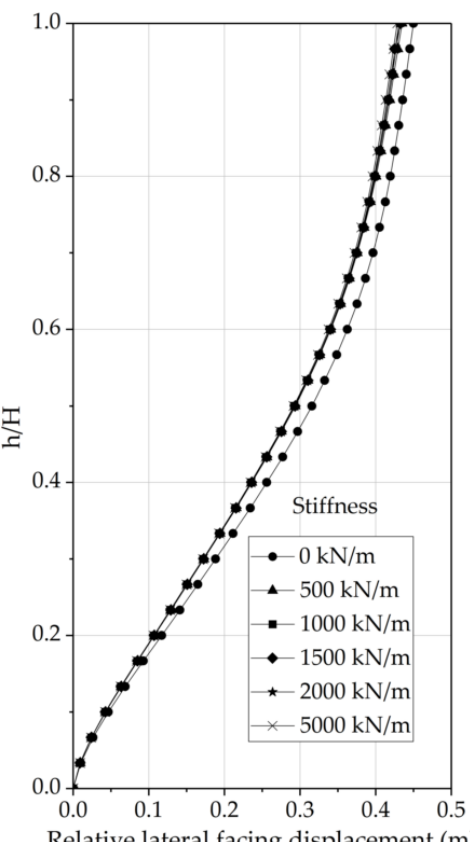
ff ect of secondary reinforcement sti ff ness on the relative lateral facing Figure 14. The effect of secondary reinforcement stiffness on the relative lateral facing displacement. Figure 14. The e